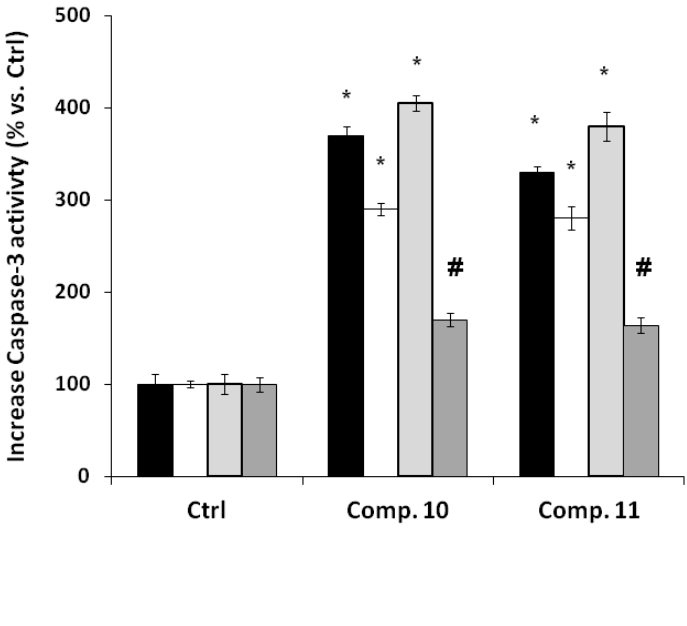
Figure 6. Effect of ent -cyclozonarone and compound 11 on caspase-3 activity of DU-145 (black), PC-3 (white), HT-29 (light grey) and DHF (dark grey) cells. Cells were exposed to compounds at 25 µM and incubated for 24 h. Values are mean ± S.D. ( n = 3). All data are reported as the percentage change in comparison with the vehicle-treated cells, which were arbitrarily assigned 100%. * p < 0.05, significantly different from the vehicle-treated cells (1% ethanol in medium, that is, compound concentration = 0) # p < 0.001, significantly different from the vehicle-treated